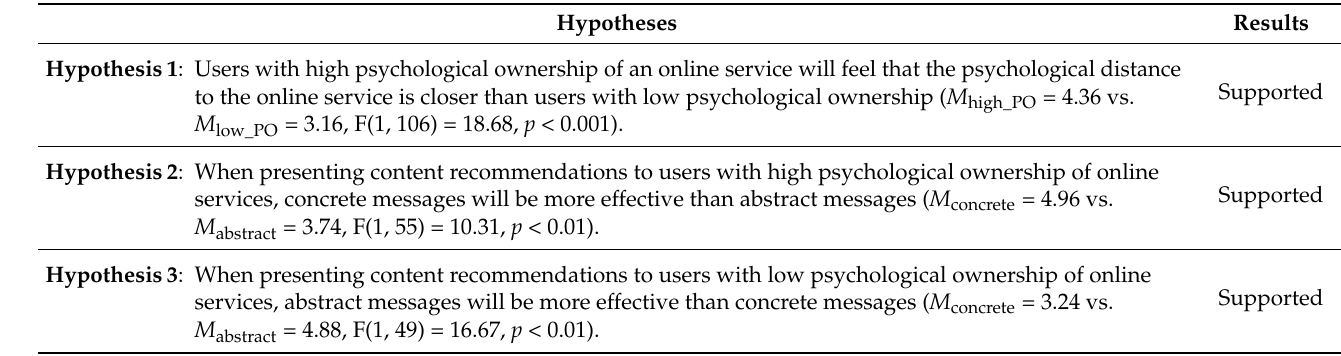
Table 6 summarizes the results of hypotheses with main statistical parameters. Con- sequently, all the proposed hypotheses were statistically significant. Table 6. Results of